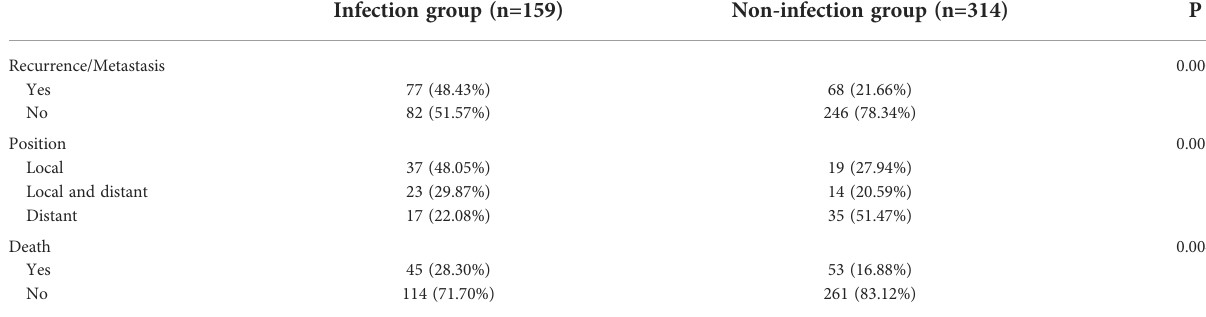
TABLE 4 Prognosis.